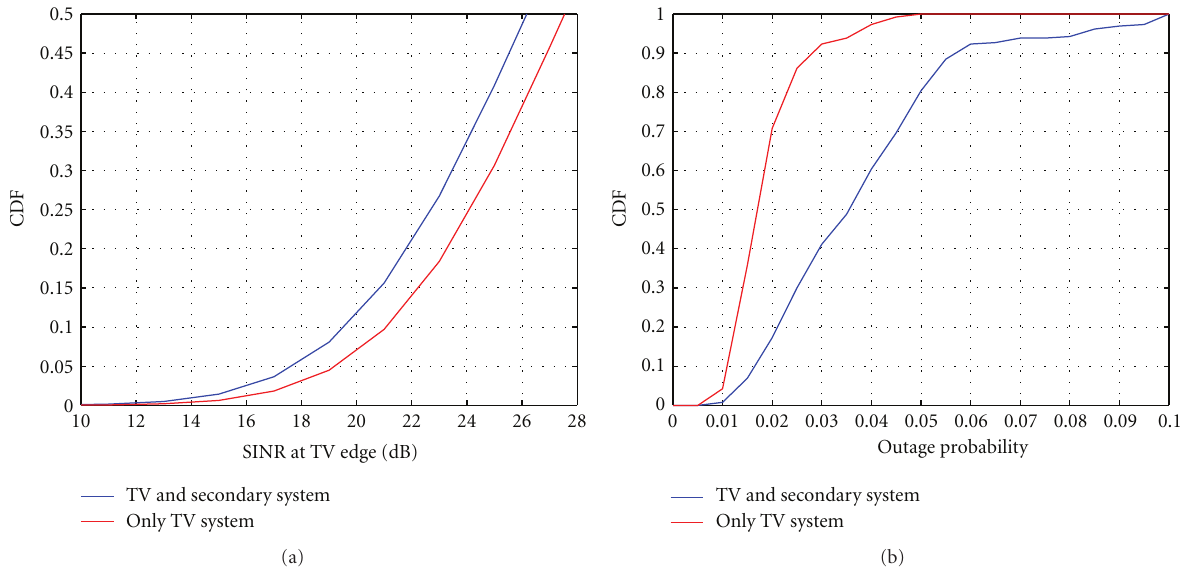
Figure 10: (a) SINR distribution at the TV test points. (b) Distribution of the outage probability at the TV test points.